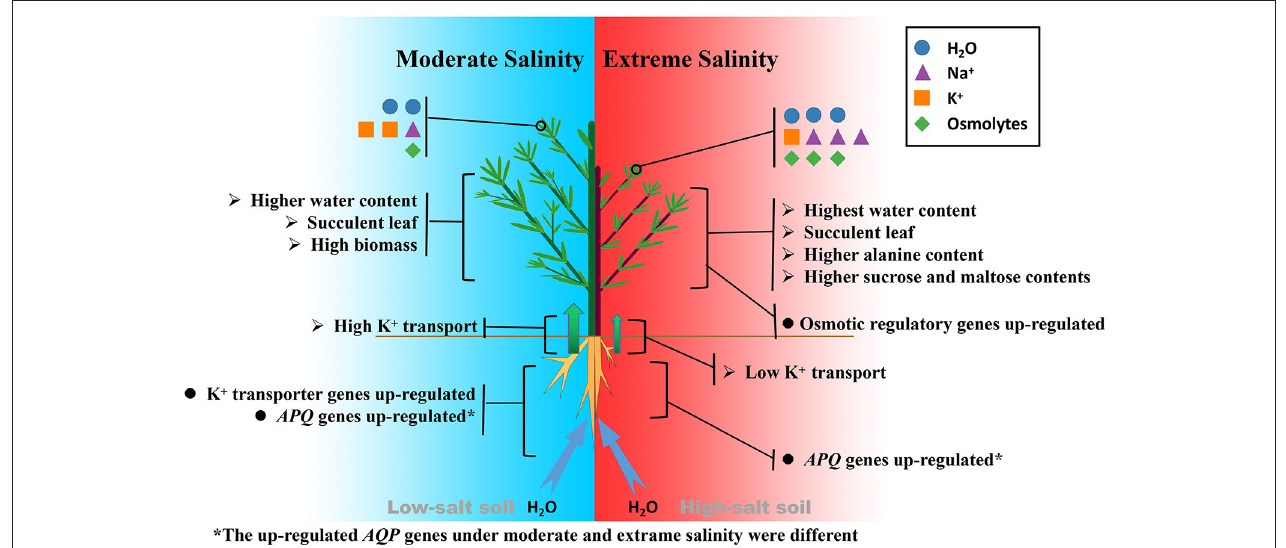
FIGURE 7 | Comparison of salt tolerance mechanisms of K. sieversiana under moderate and extreme salinity stresses.